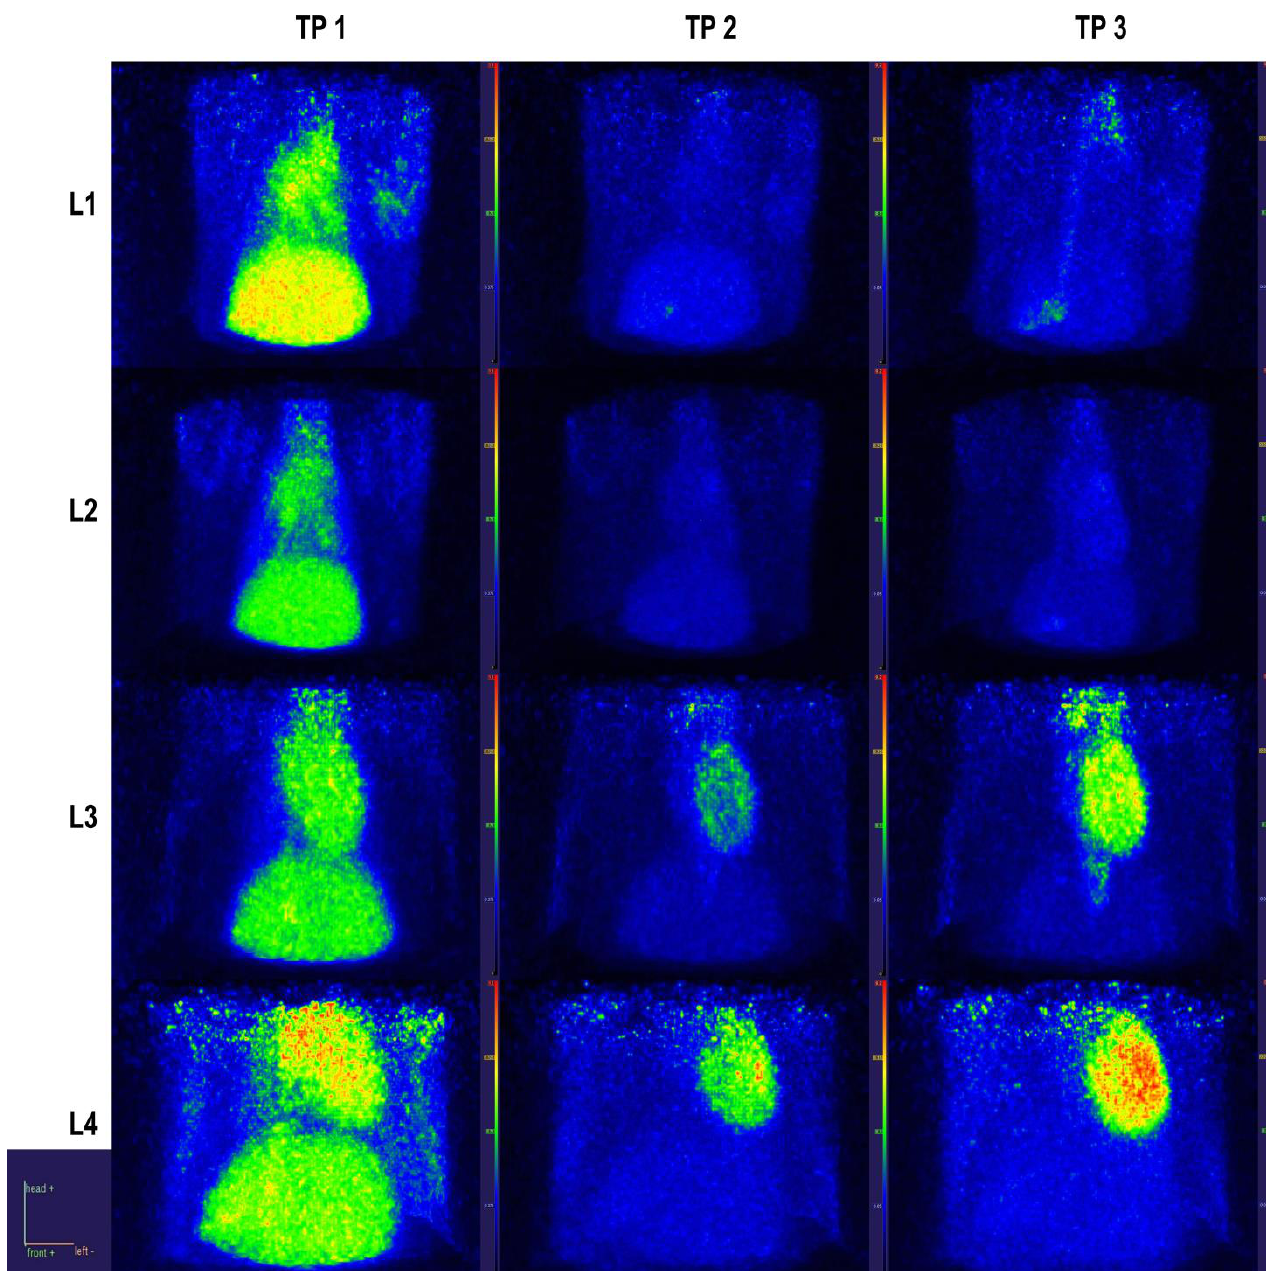
Figure 7. Heart and liver close-ups in parametric maximal intensity projection images with voxel-wise normalization to blood SUV, depicting different behaviors of 18 F-FDG according to time interval and group (Note: the orange-red and yellow color represents the highest uptake regions, blue and green colors show areas of decreased metabolic activity).